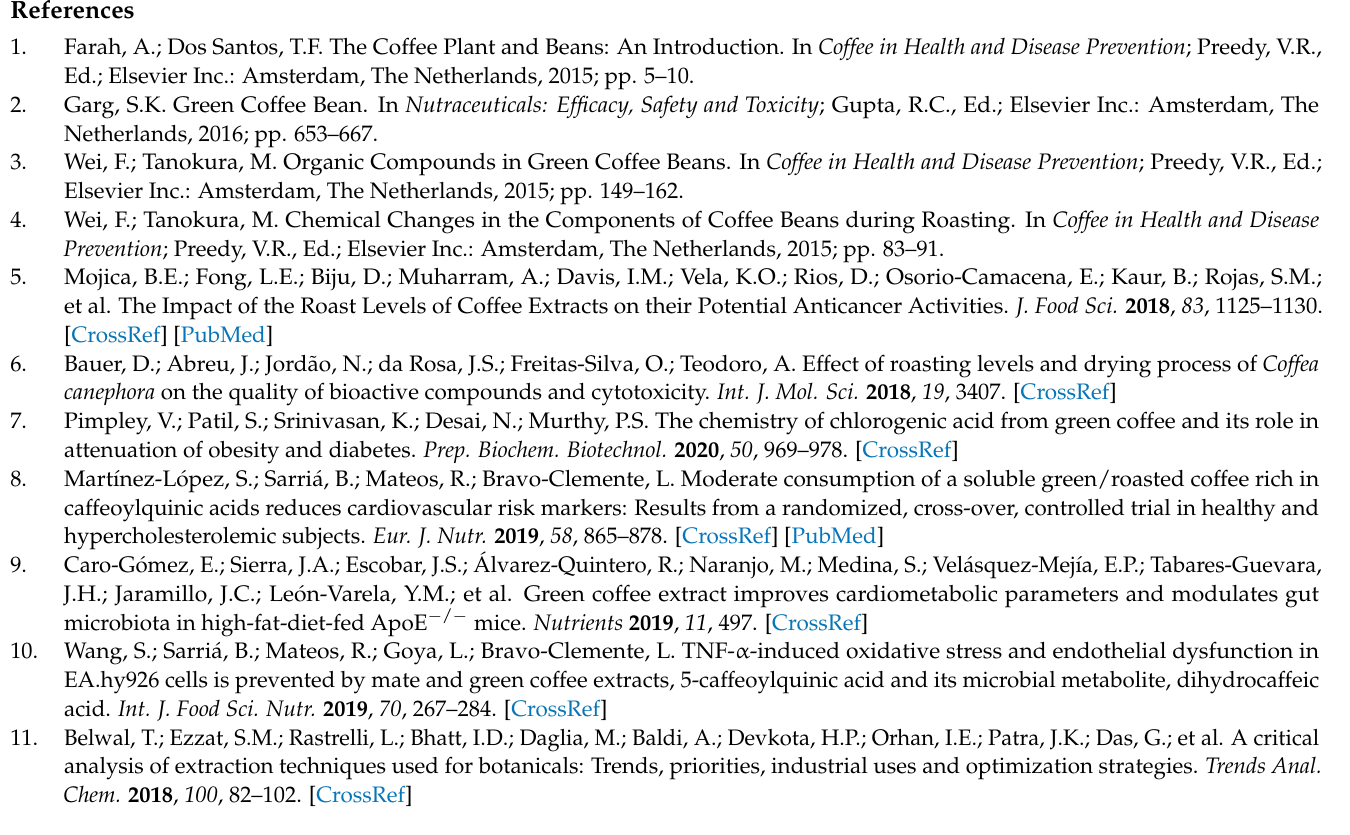
Figure S2: UV chromatogram of sample S20; Figure S3: UV chromatogram of sample S40; Figure S4: UV chromatogram of sample S60; Figure S5: UV chromatogram of sample T24; Figure S6: UV chro- matogram of sample T44; Figure S7: UV chromatogram of sample T46; Figure S8: UV chromatogram of sample U23; Figure S9: UV chromatogram of sample U34; Figure S10: UV chromatogram of sample U35; Figure S11: UV chromatogram of sample UT; Table S1: includes the analytical parameters of the database, such as retention time, precursor m/z, and specific ions used for the identification of the polyphenolic compounds, as well as the MS analysis